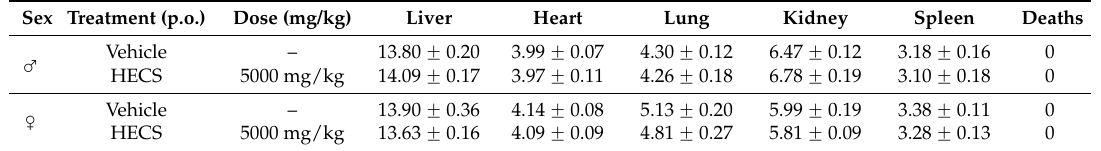
) and female ( ) Swiss mice ( n = 10) through the oral route (p.o.). ♀ ♂